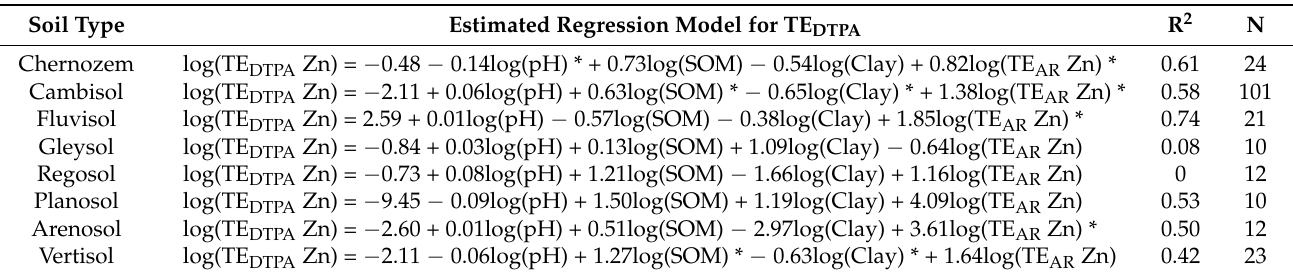
Table 12. Prediction model 9.